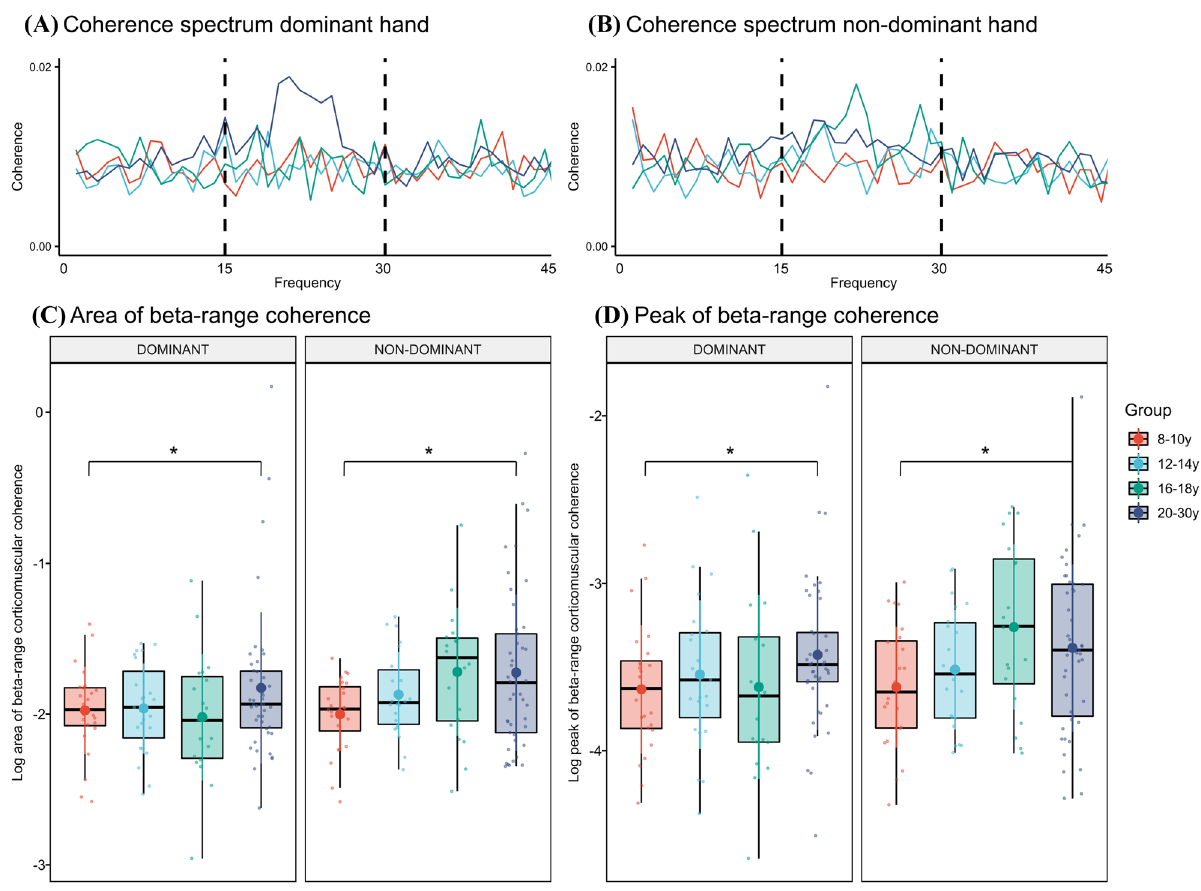
Figure 4. Beta-band corticomuscular coherence. Average coherence spectra for the dominant ( A ) and non- dominant hand ( B ) alongside box plots with individual data points and means displaying age-related differences in the log area ( C ) and peak ( D ) of beta-band corticomusclar coherence between cortical source activity and EMG activity from FDI muscles on the dominant and non-dominant hand. Statistically significant differences from the 8–10 y group are marked by * (p <